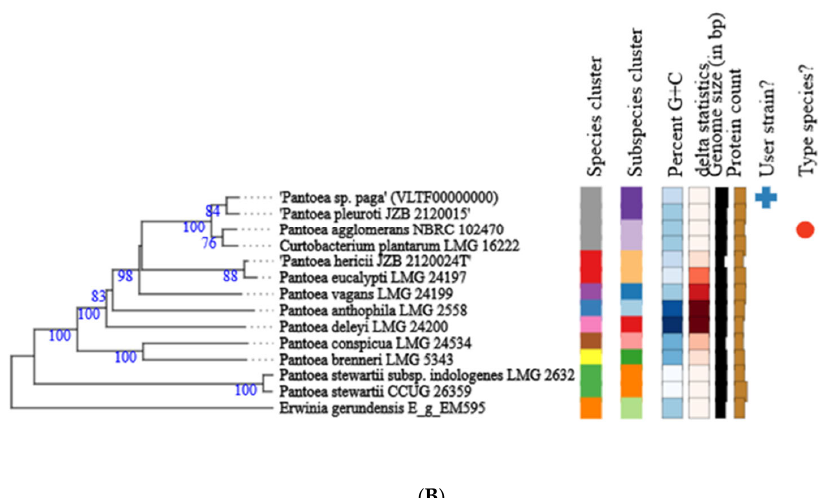
Figure 5. Phylogenetic tree of Pantoea paga strain calculated from 16S rDNA gene sequences ( A ); phylogenetic tree of Pantoea paga strain calculated from whole genome sequences ( B ). Different colors within each column indicate different minimum, maximum and intermediate values; + represents user strain and red dot indicates type species.